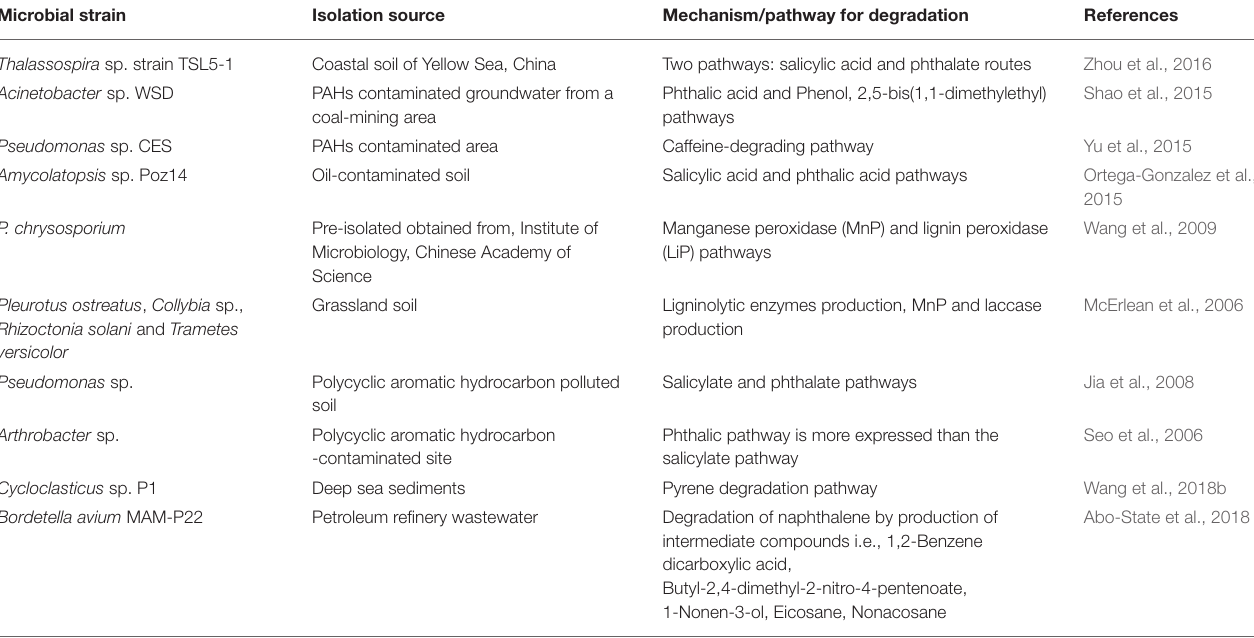
TABLE 4 | Pathways used by microbial strains for the degradation of polyaromatic